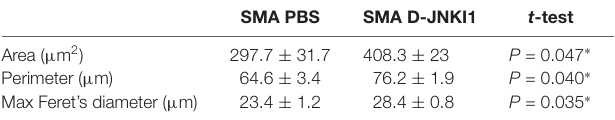
TABLE 2 | Analysis of quadriceps fiber area, perimeter and maximal Feret’s diameter in PBS-treated and D-JNKI1-treated spinal muscular atrophy (SMA) mice.